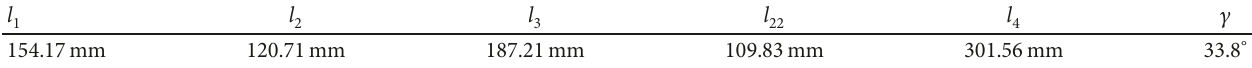
Table 1: The size parameters of each link of mechanism model.